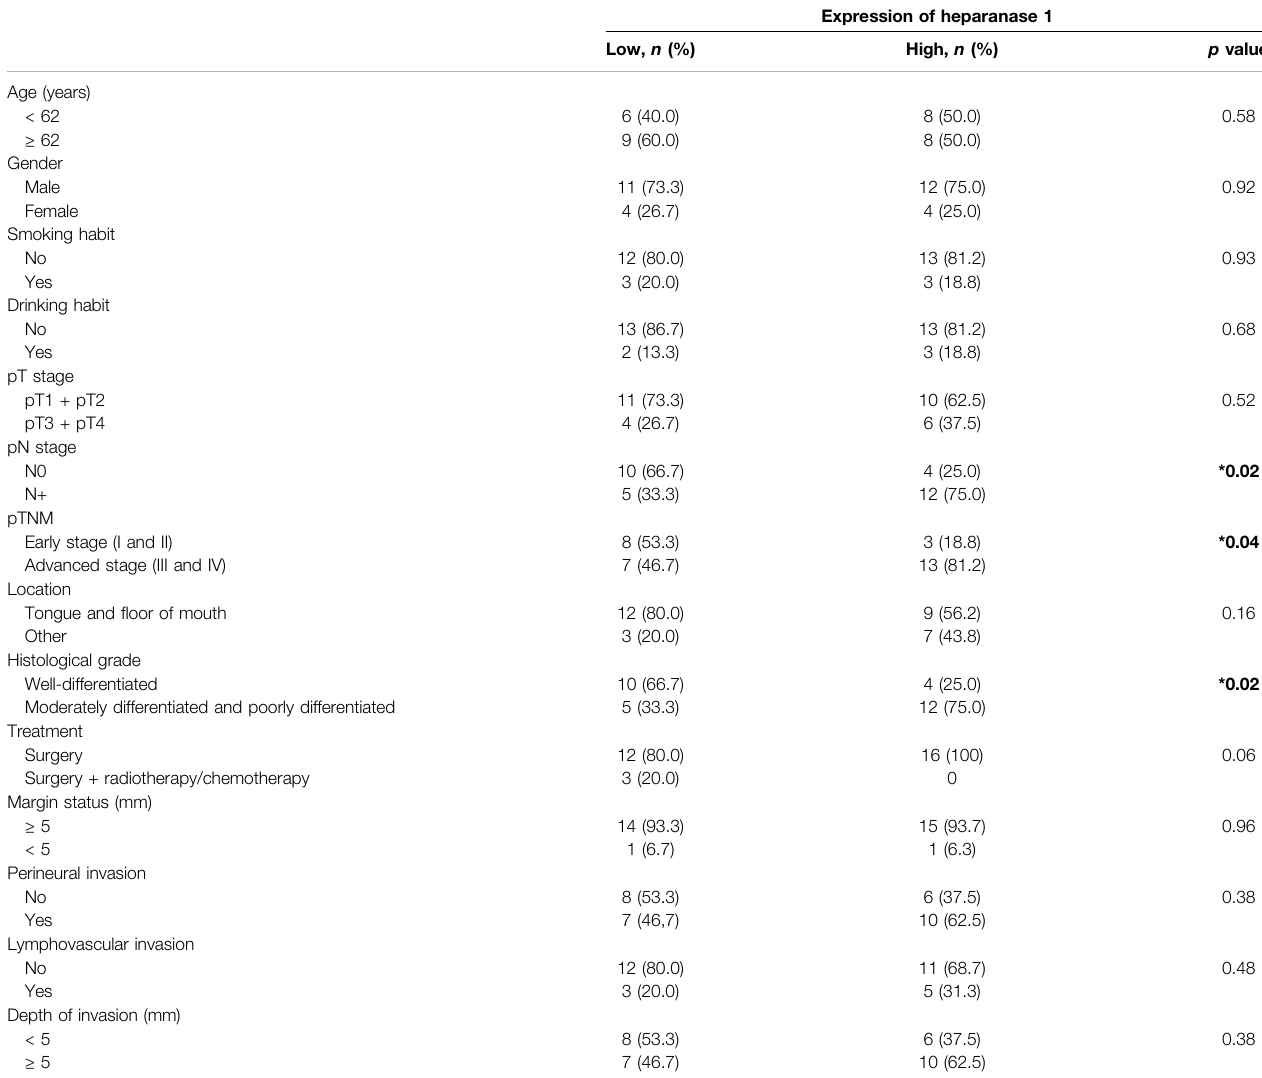
TABLE 1 | Association of expression of heparanase 1 with clinicopathological parameters of